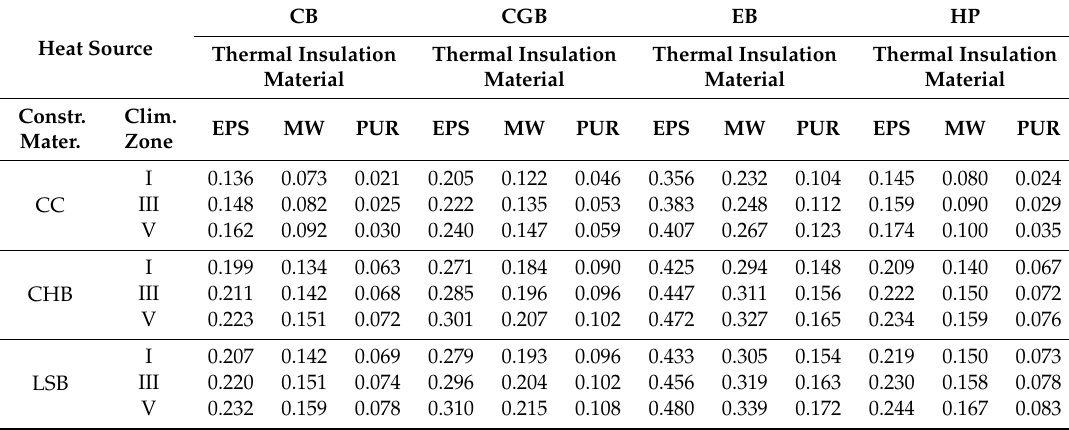
Table 6. Thermal insulation thickness d opt [m] optimum for economic reasons. CB CGB EB HP Heat Source Thermal Insulation Thermal Insulation Thermal Insulation Thermal Insulation Material Material Material Material Constr.